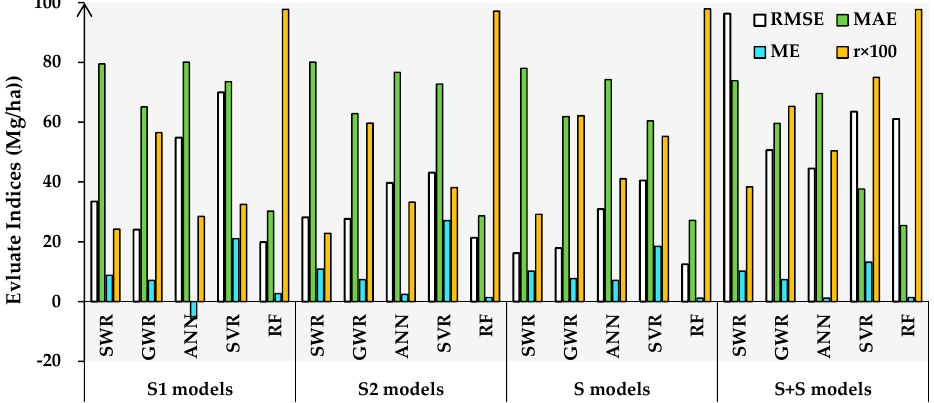
Figure 5. Accuracy assessment of S1, S2, S, and S + S models, based on SWR, GWR, ANN, SVR, and RF algorithms.